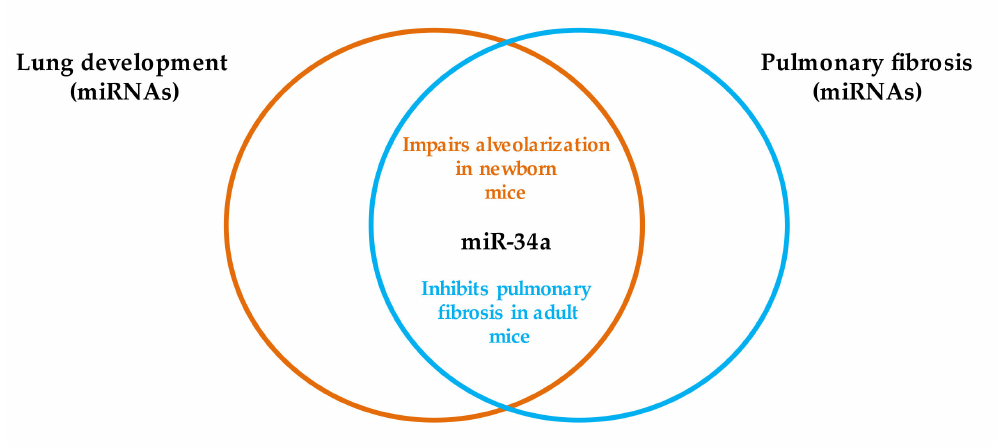
Figure 3. miR-34a regulates lung development and the pathogenesis of pulmonary